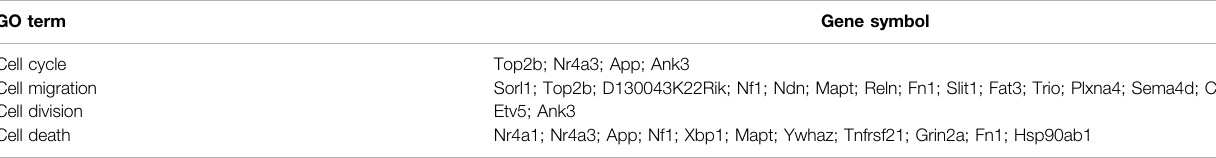
TABLE 1 | GO analysis of differentially expressed neurogenesis-related genes in brains of C1KO, as compared to WT mice. GO term Gene symbol Cell